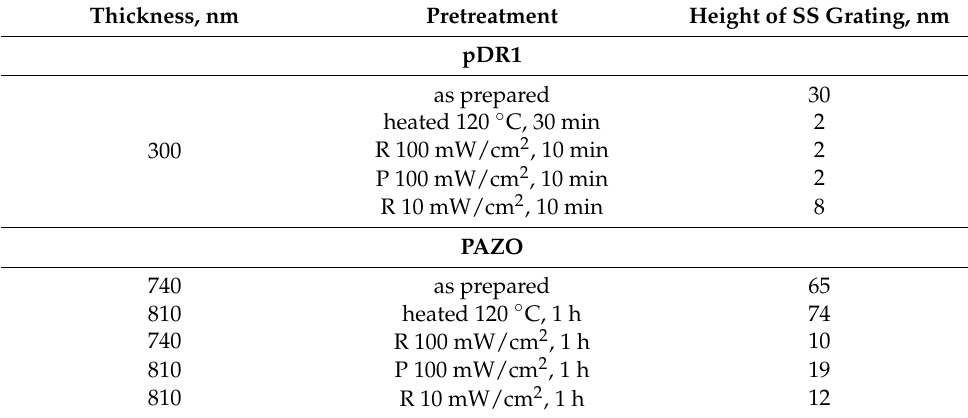
Figure 4. Modeled SS gratings inscribed on the 1 µm thick film after 25 s at free BCs along the polarization direction for two initial backbone orientations: ( a ) case 1 and ( b ) case 2. The local distribution of the electric field vector is depicted by white arrows. The initial light-induced stress is 25 MPa. ( c ) AFM micrograph of the 300 nm thick pDR1 polymer film irradiated with SS IP for 1 h. The polymer film is scratched before irradiation to allow for the boundary deformation. Table 1. The height of SS grating ∆ h inscribed on pDR1 and PAZO after different pretreatments. Thickness,